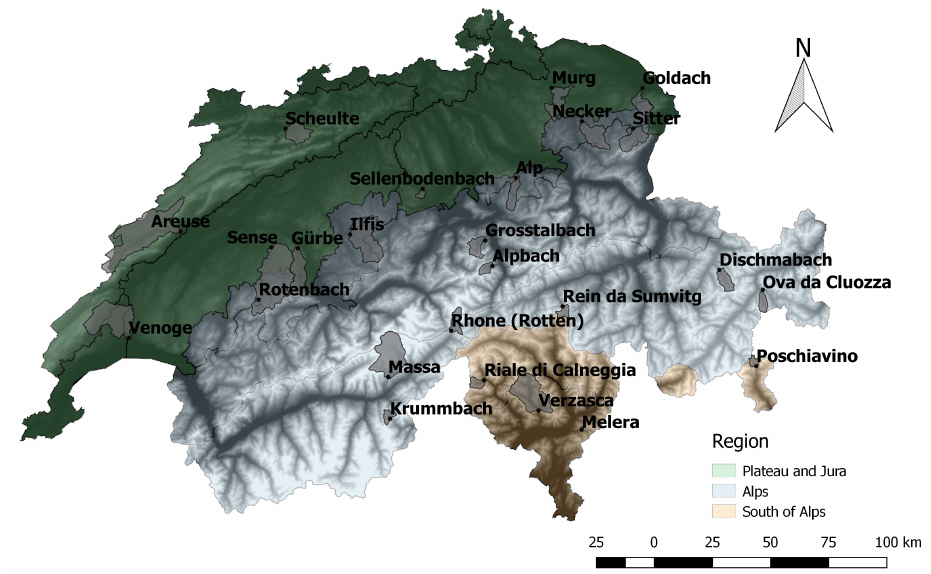
Figure 3. Location of the case study catchments in Switzerland. The six biogeographical regions of Switzerland (Federal Office for the Envi- ronment, 2004) are summarized here into three main regions. Data source as follows: digital elevation model, SwissTopo (2005); catchments, Helbling